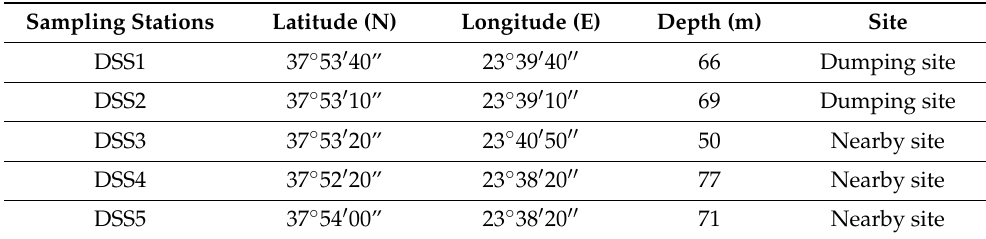
Table 1. Sampling stations with coordinates and depths during the monitoring